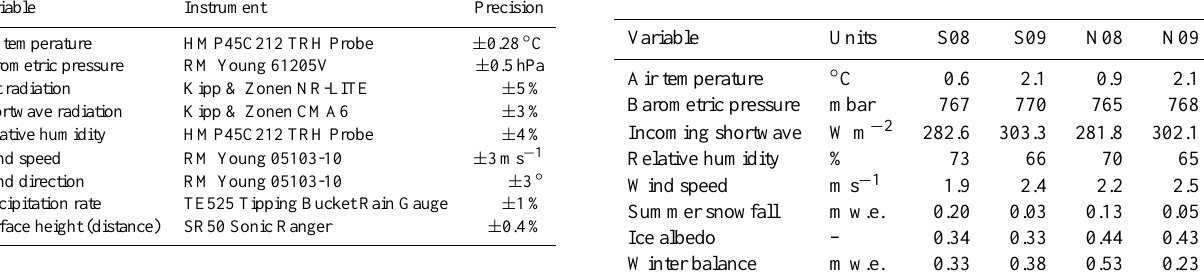
Table 2. Mean values of meteorological variables and ice albedo for North and South Glaciers as measured at AWS locations from 19 May to 28 July in 2008 and 2009. Winter balances are also shown. S08 is South Glacier 2008, S09 is South Glacier 2009, N08 is North Glacier 2008 and N09 is North Glacier